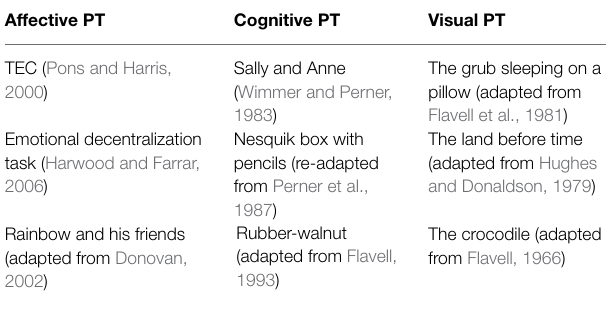
TABLE 1 | Perspective taking assessment tasks (Study